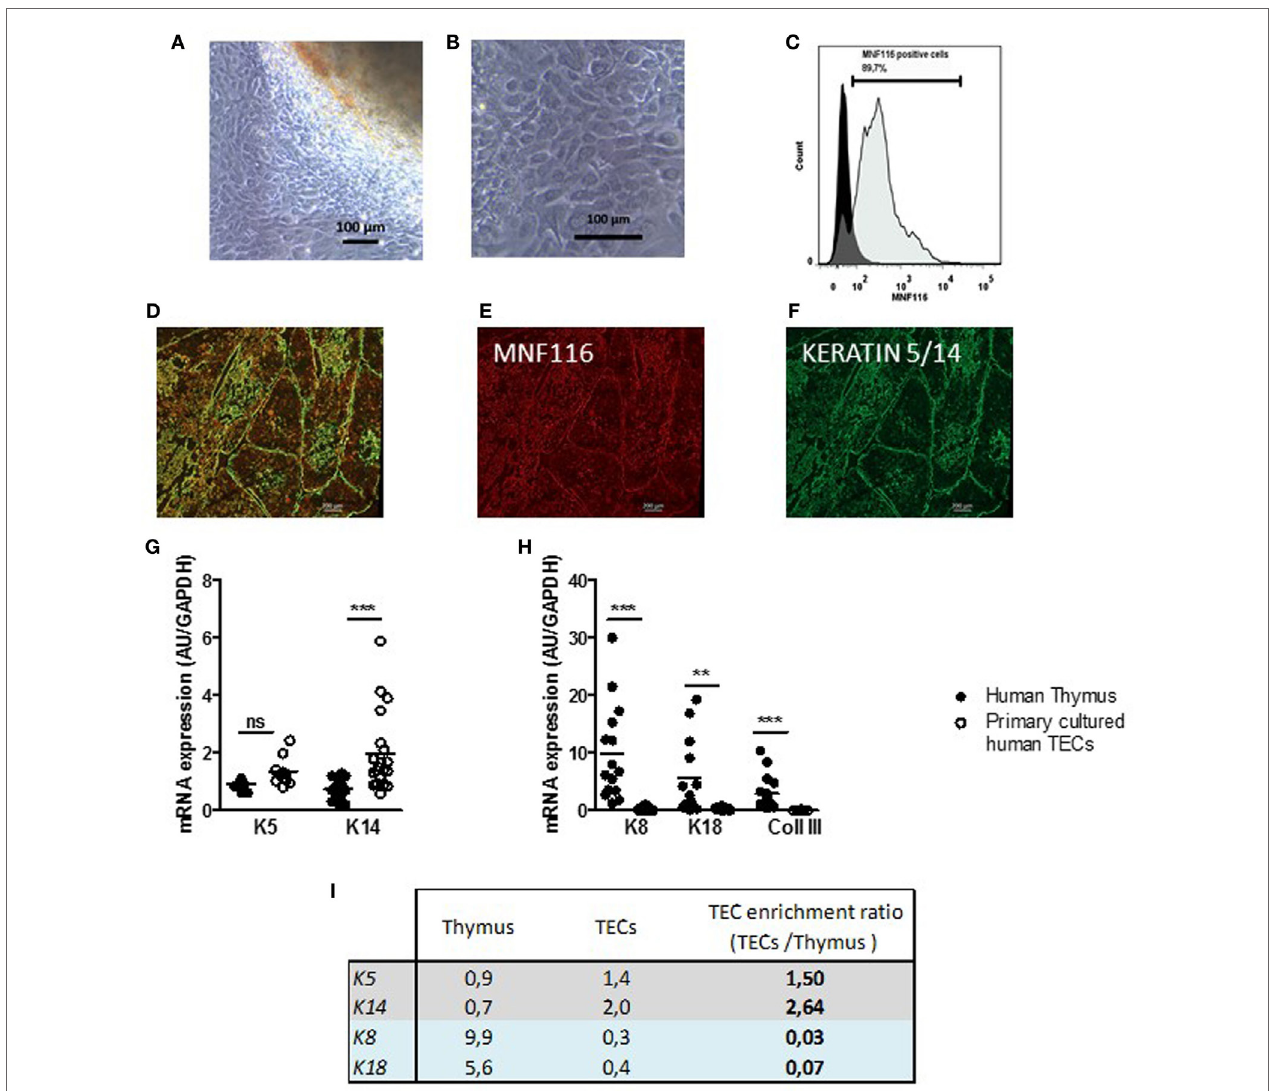
FIgURe 1 | Primary cultured human thymic stromal cells display thymic epithelial cell (TEC) features. (A,B) Representative pictures of thymic cells expanding from human thymic explants. (A) After 2–4 days of culture, cells migrate and proliferate out of the explants in culture. (B) Thymic cell culture with the morphologic mosaic form of epithelial cells. (C) Representative flow cytometry plot of primary cultured TECs labeled with an anti MNF-116 antibody; the control isotype is shown in black at a day 7. (d) . Representative pictures of primary human thymic sections (e–g) co-labeled with an anti-MNF-116 antibody (red) (e) , and anti-keratin 5 and 14 antibodies (green) (F) . Images were acquired with a Zeiss Axio Observer Z1 inverted microscope. mRNA expression levels of medulla thymic epithelial cell (mTEC) markers ( K5 and K14 ) (g) , cortical thymic epithelial cell (cTEC) markers ( K8 and K18 ), and a fibroblast cell marker (collagen III, Coll III ) (h) in human thymuses and in primary cultured TECs (day 6–7). Enrichment ratios of gene expression of specific markers for mTECs (gray) and cTECs (blue) in cultured human TECs (day 7) versus total thymus (I) . mRNAs were analyzed by real-time PCR and normalized to GAPDH for total thymuses and primary TECs. mRNAs are expressed as arbitrary units and are the mean values ( n > 9 for thymuses and n > 5 for different donors for primary cultured TECs). p Values were obtained using the ANOVA test. Asterisks indicate significant differences (** p < 0.005 and *** p <